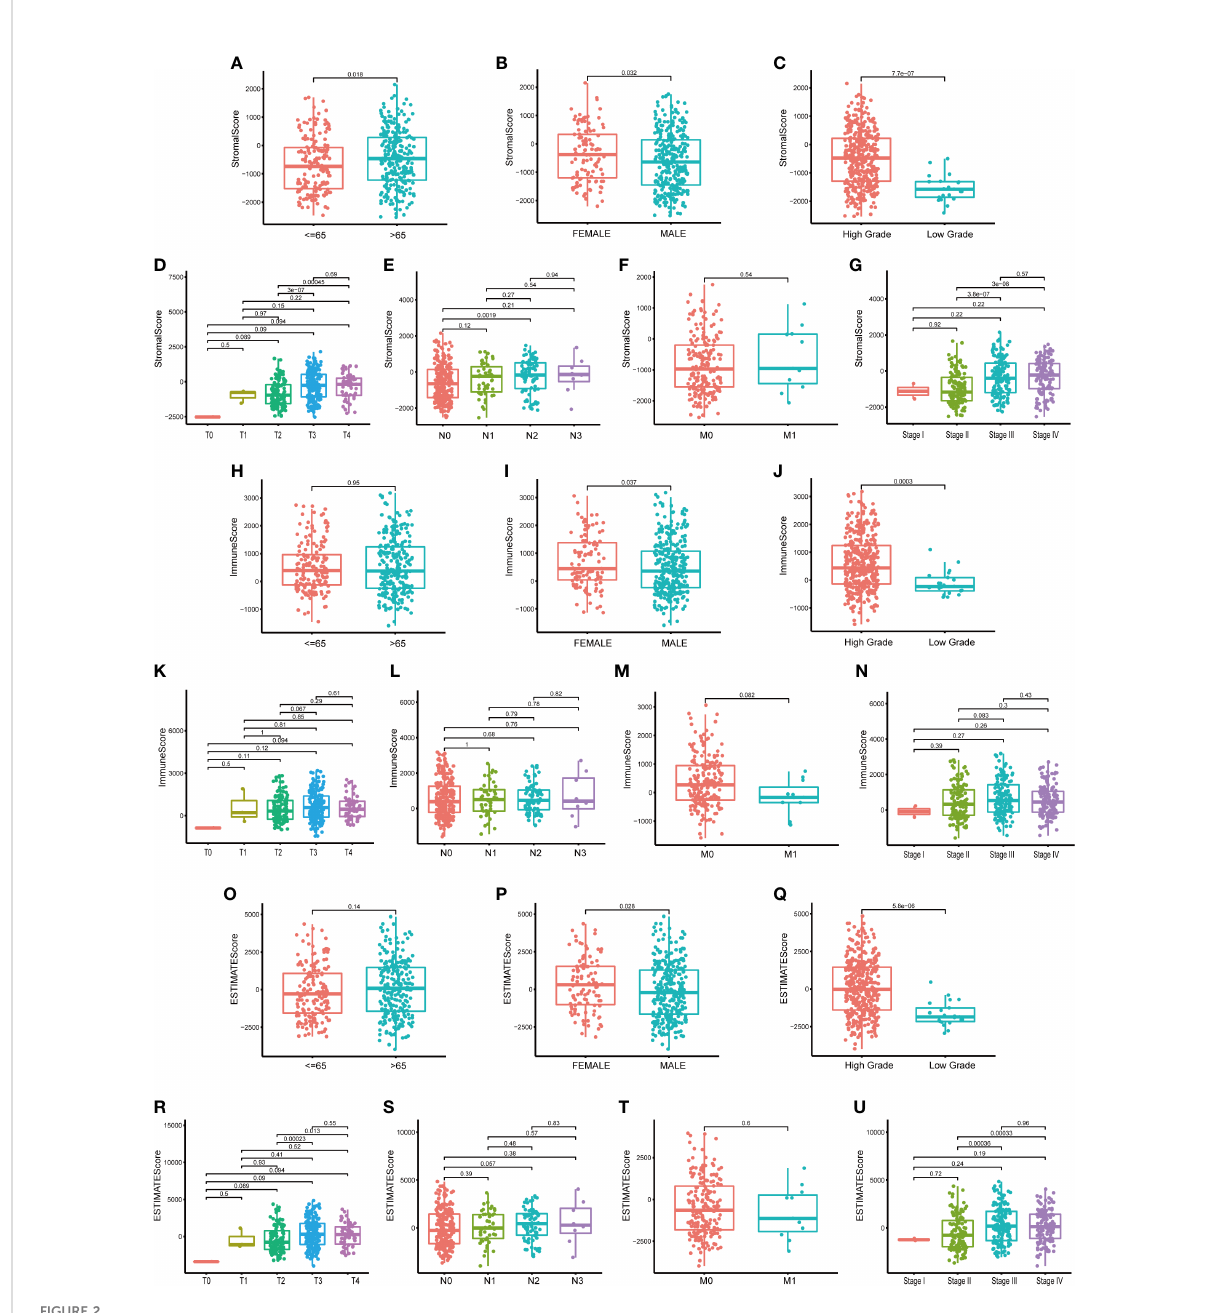
FIGURE 2 The relationship between Scores and clinic – pathological characteristics of BLCA patients. (A – G) The relationship between Stromal Score and clinic – pathological characteristics of BLCA patients, including age, gender, pathology grade, TNM classi fi cation and stage; (H – N) The relationship between Immune Score and clinic – pathological characteristics of BLCA patients; (O – U) The relationship between ESTIMATE Score and clinic – pathological characteristics of BLCA patients. P-value was showed in each